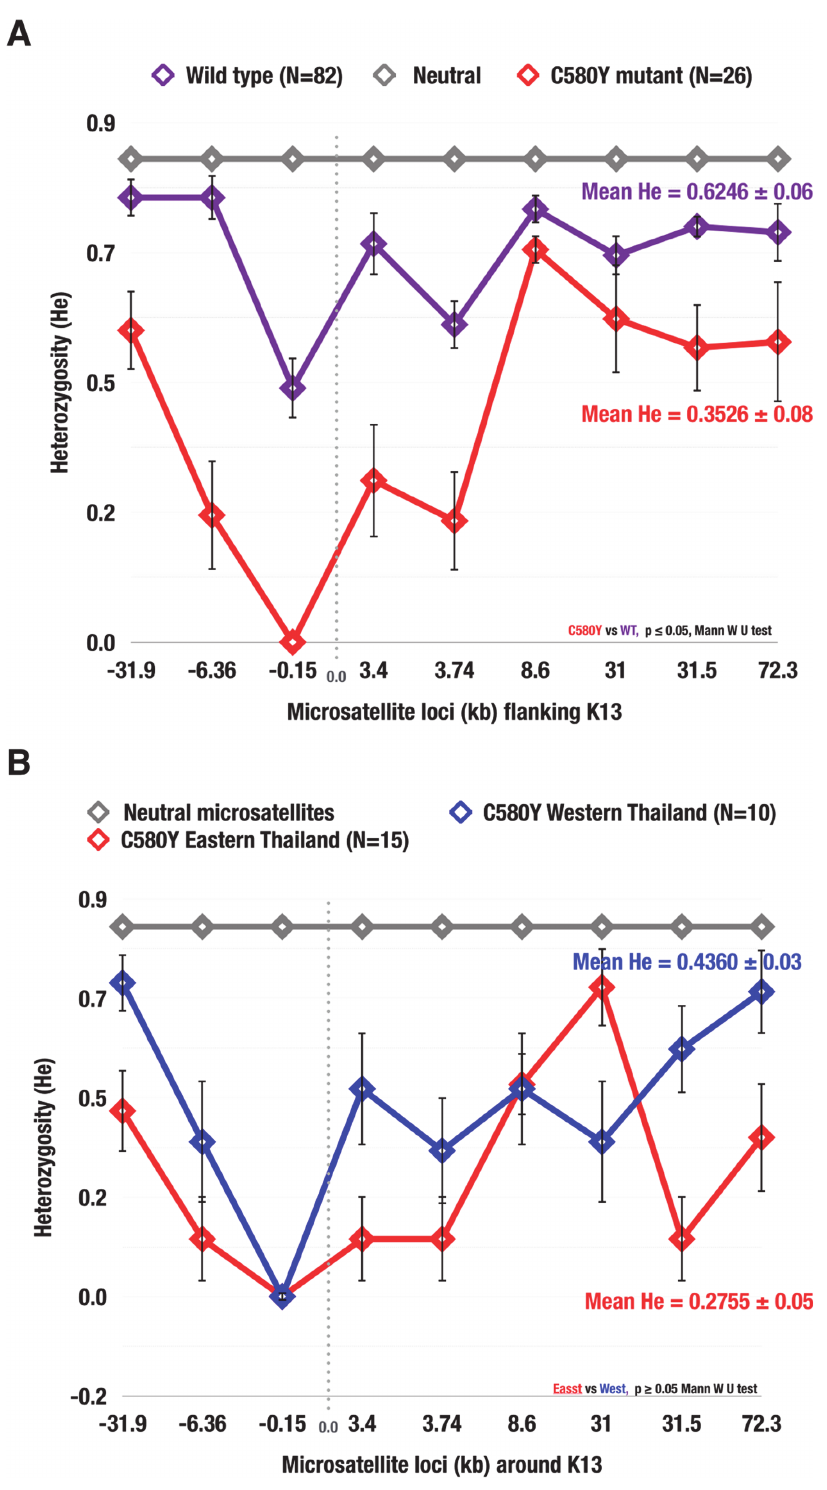
Fig 3. Heterozygosity valley around K13 propeller alleles in Thailand. The expected heterozygosity of parasite isolates with: (A) the C580Y mutation (N = 26) and wild type alleles (N = 82); (B) the C580Y from the east (N = 10) and west (N = 16). Diversity was reduced at all 9 K13 propeller microsatellite loci for C580Y compared to wild type alleles. The mean H e in (A) for C580Y (0.3526 ± 0.08), wild type (0.6246 ±